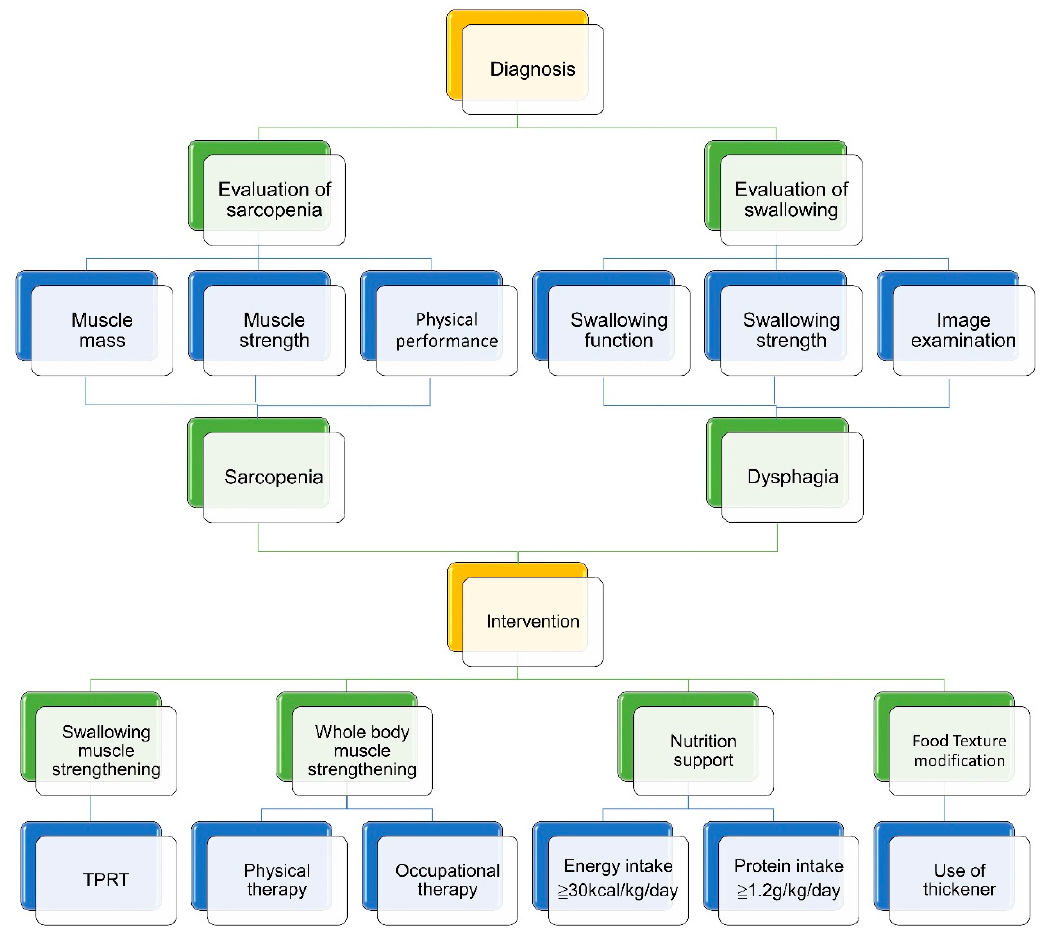
Figure 11. An integrated protocol for managing patients with sarcopenic dysphagia. TPRT, tongue-pressure resistance